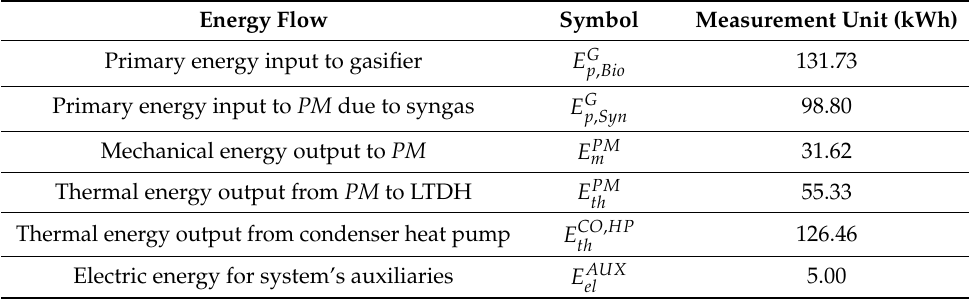
Figure 28. Biomass-fired air source GEHP serving a low-temperature district heating network. Table 2. Biomass-fired GEHP